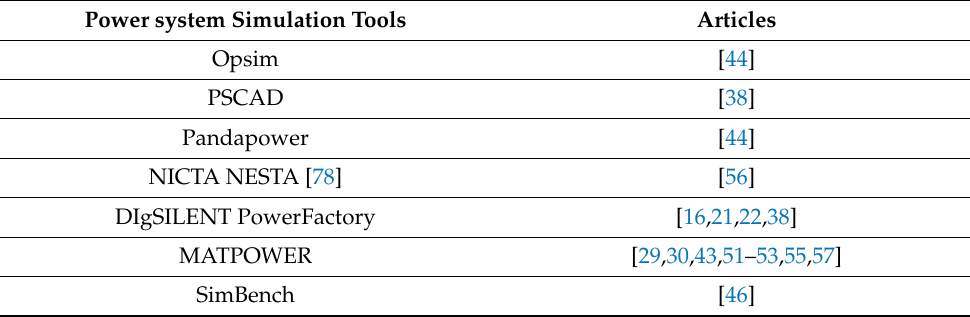
Table 6. Power system simulation tools.